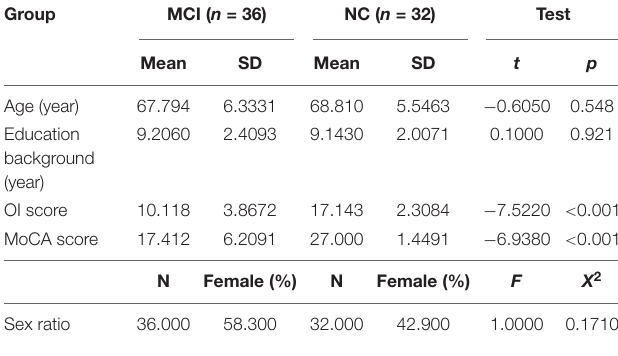
TABLE 1 | Demographic information of participants.